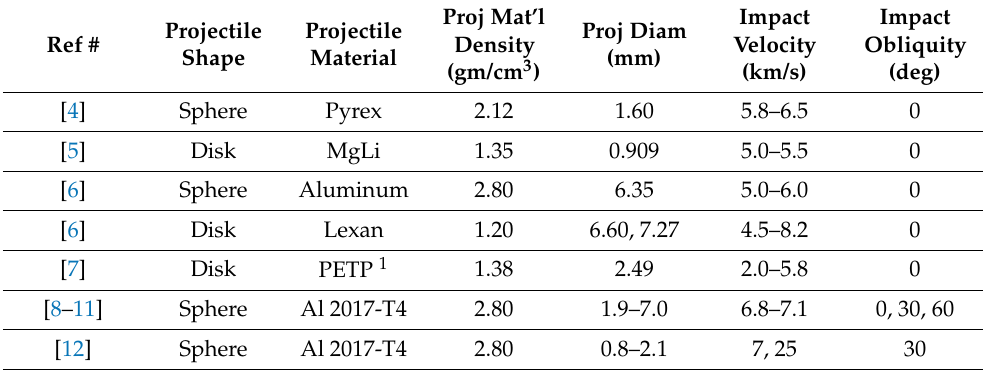
Table 1. Impact Conditions in Previous Experimental Programs and Numerical Simulations.